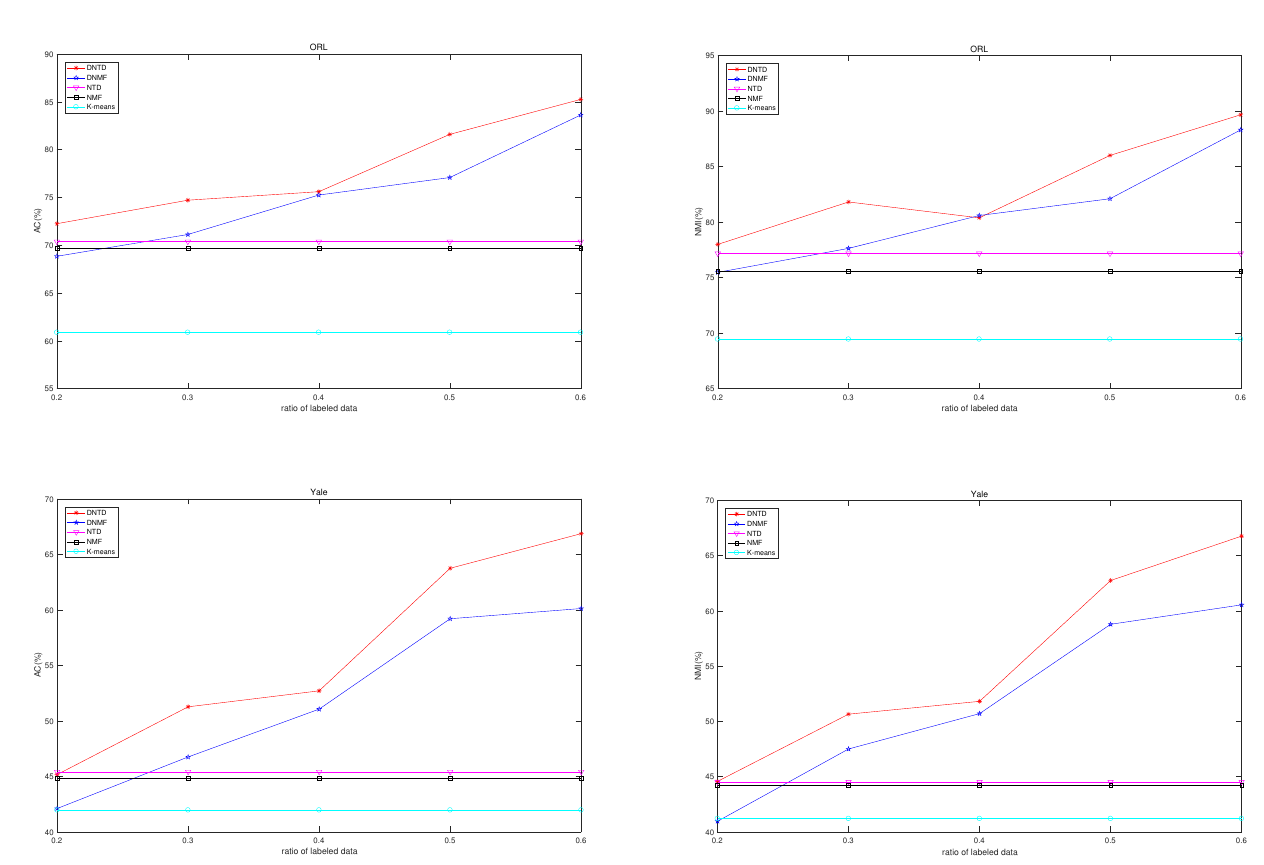
Figure 1. The clustering performance with varied labeled sample data on ORL and Yale